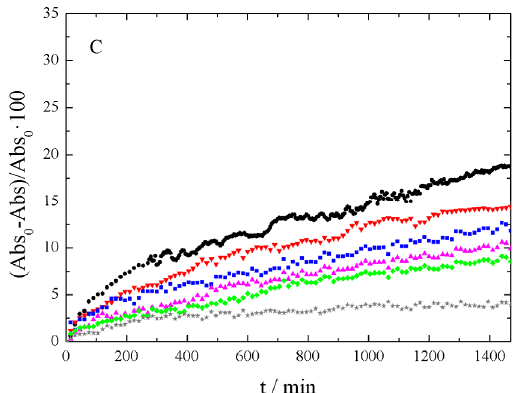
Figure 6. Absorbance decrease, 100 (Abs0 − Abs)/Abs0, at λ = 250 nm and different sonication time ( ● 1 h, ▼ 2 h, ■ 3 h, ▲ 4 h, ♦ 5 h, and 6 h) of ( A ) xGnP/PG, ( B ) xGOnP/PG and ( C ) r ‐ xGOnP/PG nanofluids, 0.003 wt%, T = 298.15 K.